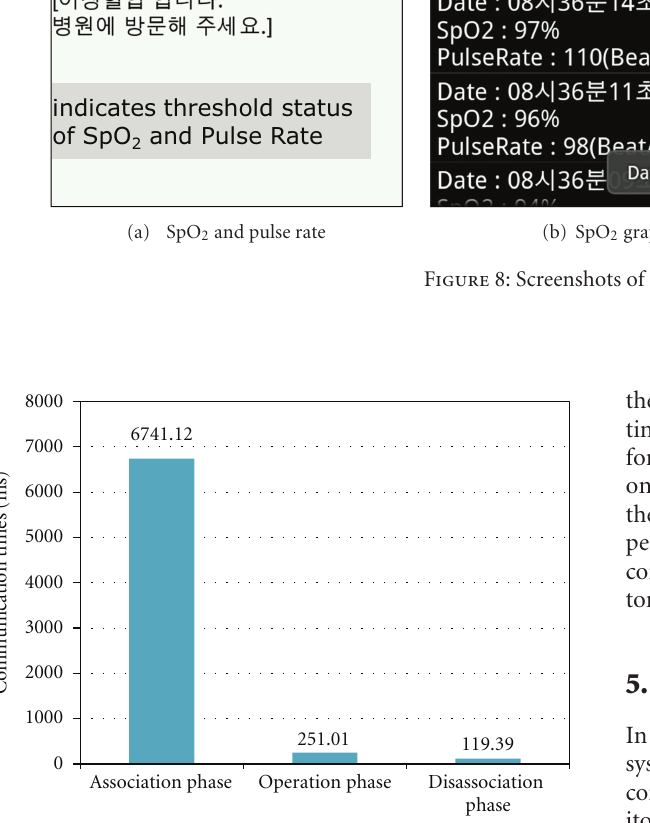
Figure 9: Communication times of pulse